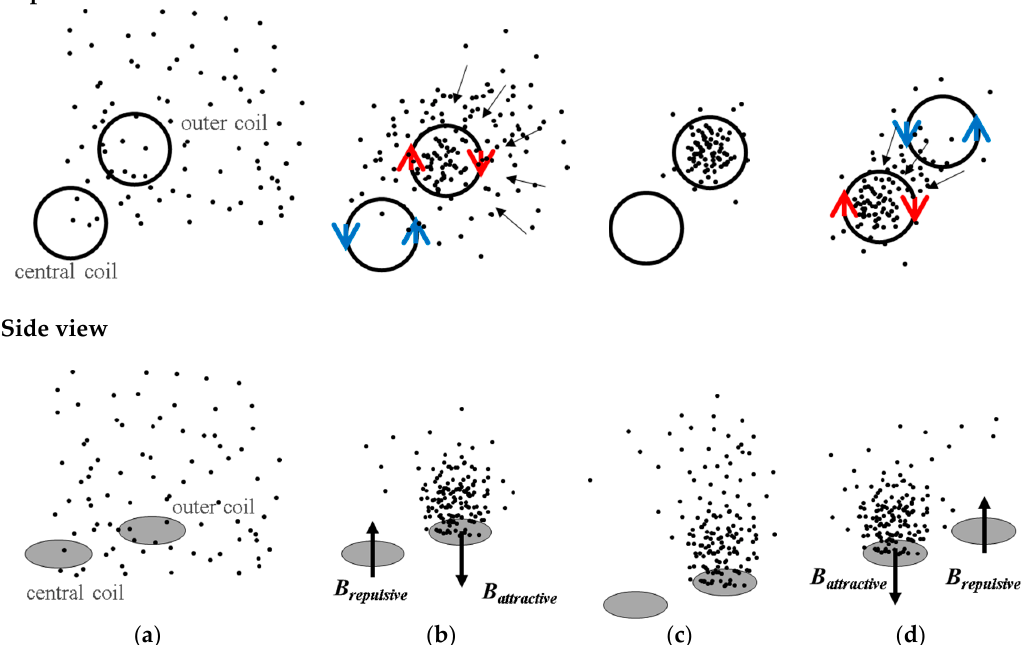
Figure 4. Schematics of ¼ of the MEMT system and magnetic beads (MB) concentration/dispersion process. The red and blue arrows (top views) indicate the current flow while the black arrows (side views) indicate the direction of the magnetic flux density. ( a ) MB are moving freely in the flow with uniform distribution. During the trapping experiments, without flow, the current is set to the coils for the magnetic actuation to start. ( b ) The concentration of MB in the outer coils results from both the inward electromagnetic force generated at the outer coils and the outward electromagnetic force at the central coil. ( c ) Instantaneous interruption of the current. ( d ) When the direction of the current is inverted, and consequently the magnetic forces, the MB previously concentrated over the outer coils are then oriented towards the central coil.